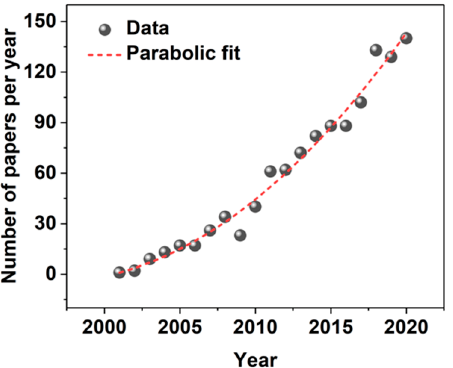
Figure 1. The number of papers per year indexed by the Scopus database under the terms “carbon nanotube*” and “textiles” as of the 19 July 2021.